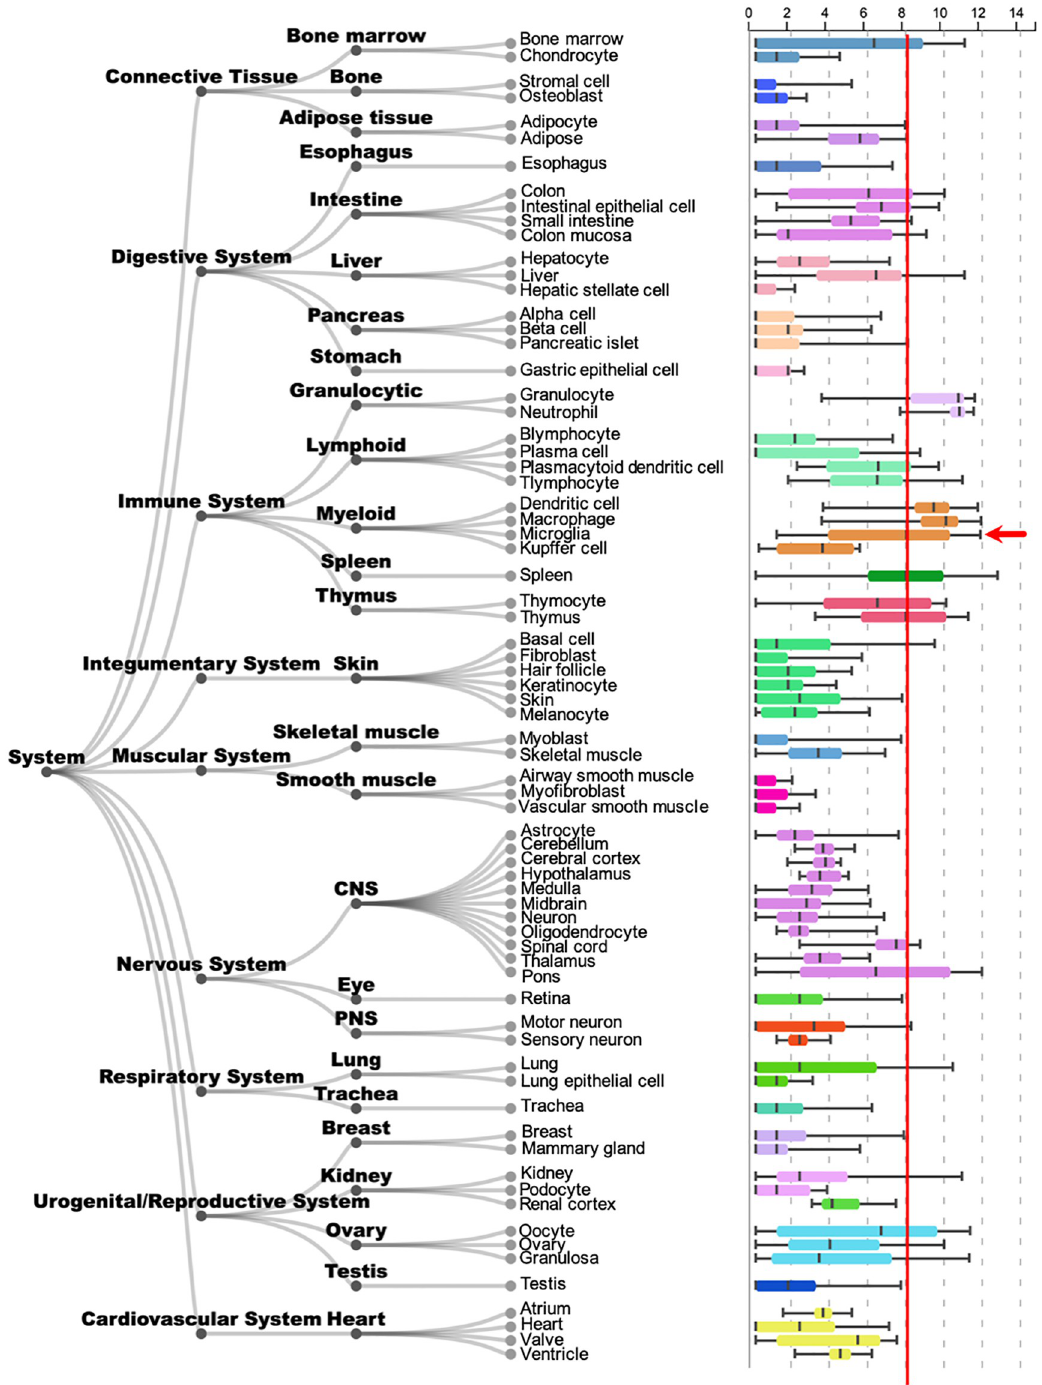
Fig 1. Tissue expression of Aoah / AOAH mRNA. Boxplot obtained from the public RNAseq data analysis tool ARCHS4 showing Aoah / AOAH expression in different tissue types. For comparison of microglia (arrow) relative to other cell types, approximate mean microglial expression is indicated (red line) [41].